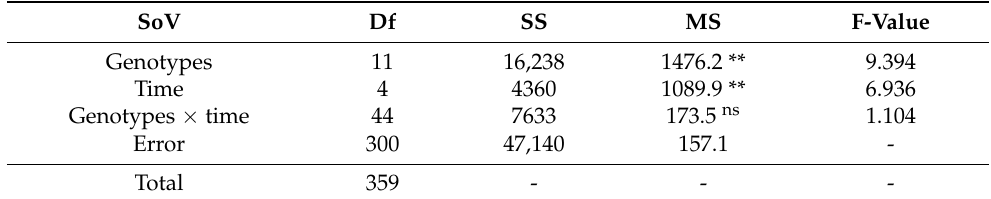
ns = non-significant; ** highly significant ( p <